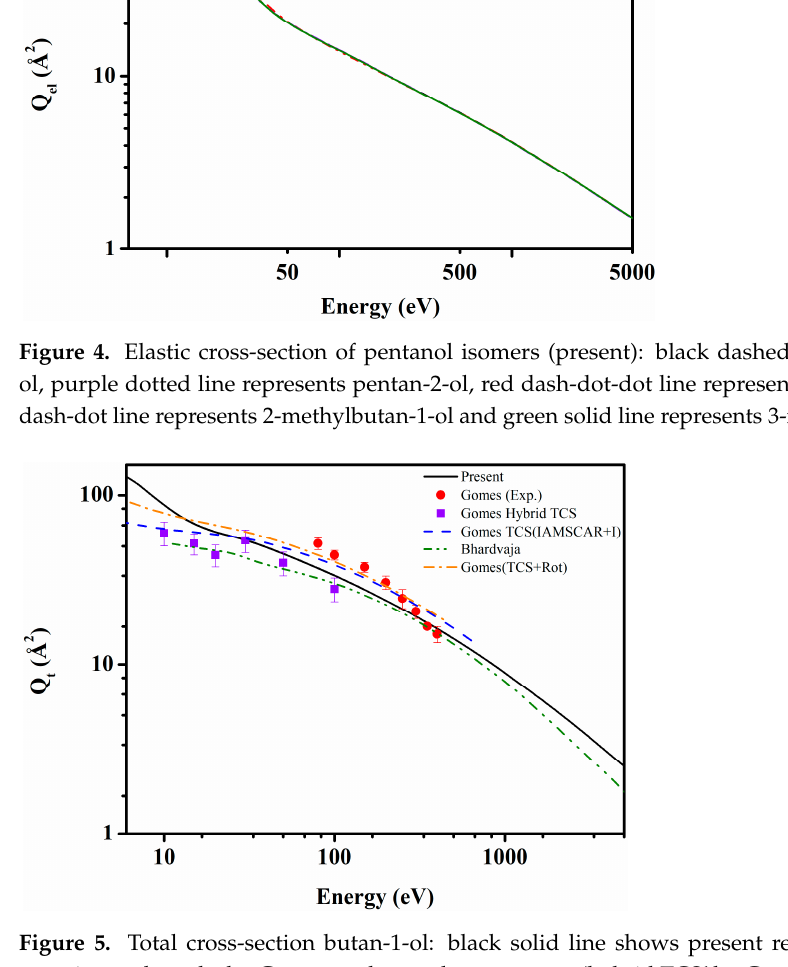
Figure 6. Total cross-section of butanol isomers (present): solid (black) line represents butan-1-ol, dashed (olive) line is for butan-2-ol, dash-dot (red) line is for 2-methylpropan-1-ol and dash-dot- dot (blue) line represents 2-methylpropan-2-ol. Our calculated TCS of pentan-1-ol (Figure 7) is in very good agreement with the cal- culated results of Bhardvaja et al. [30], except for very low and very high energies. There are no experimental results available for the same to the best of our knowledge for com- parison with our data. Interestingly, the TCS results of pentanol isomers (Figure 8) inher- ited the same features from their elastic cross-sections and here again, 3-methylbutan-2-ol displays a deviation from the trend observed in butanol isomers.